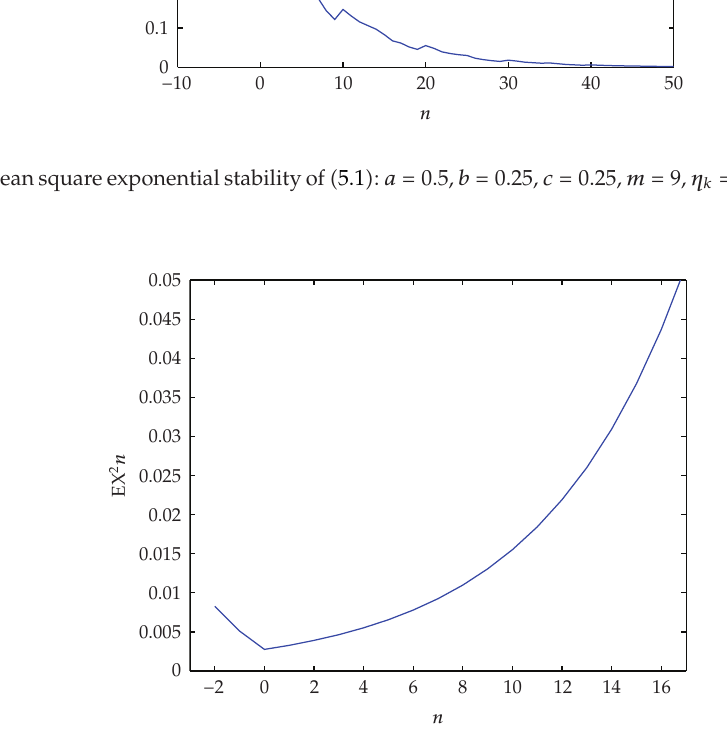
Figure 2: Instability without impulsive e ff ects of (cid:3) 5.1 (cid:4) : a (cid:7) 1 . 09, b (cid:7) 0, c (cid:7) e − 19 , and m (cid:7)